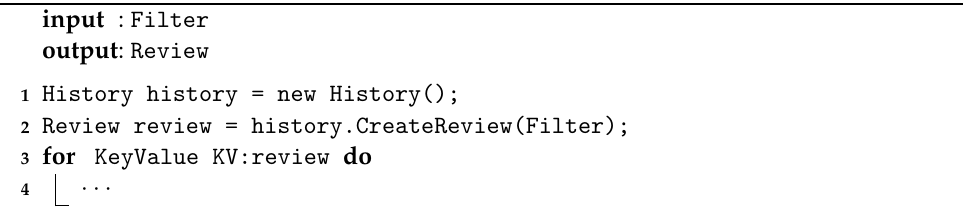
Algorithm 1 : A code example of extracting and loading data items during the